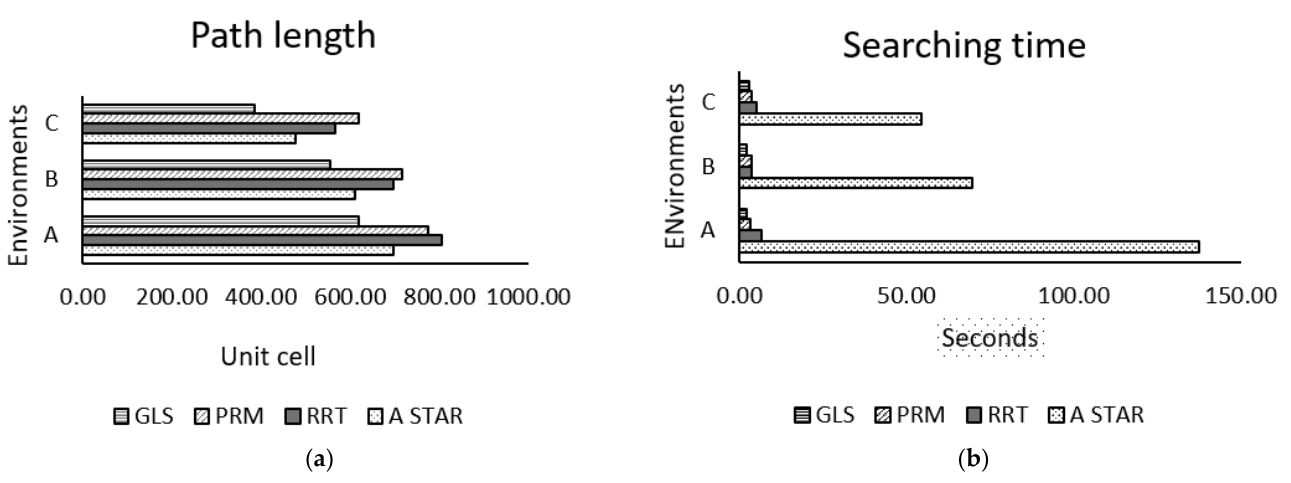
Figure 12. Mean values of the fifteen trials in Tables 2 and 3 for GLS, PRM, RRT, and A* algorithms in environments A, B, and C: ( a ) path length, ( b ) searching time. Table 2. Shows distance comparison between GLS and other algorithms, measured in unit